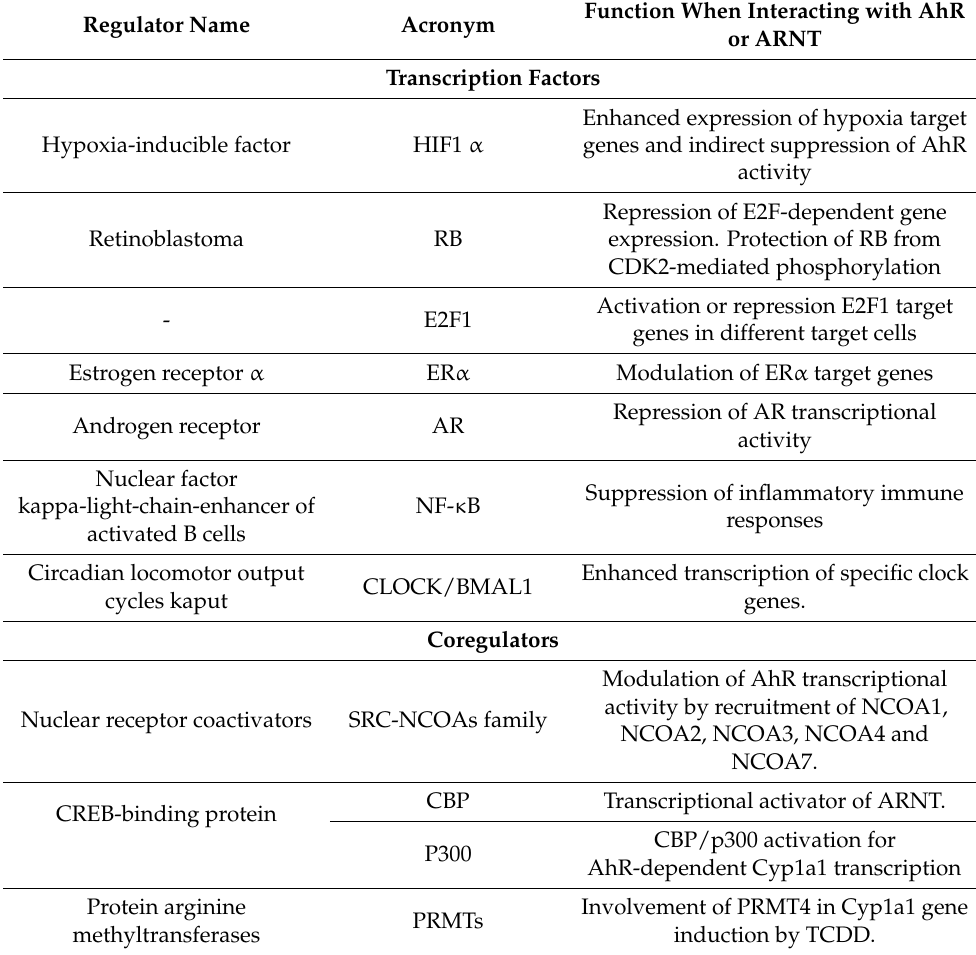
Table 1. The landscape of factors regulating AhR